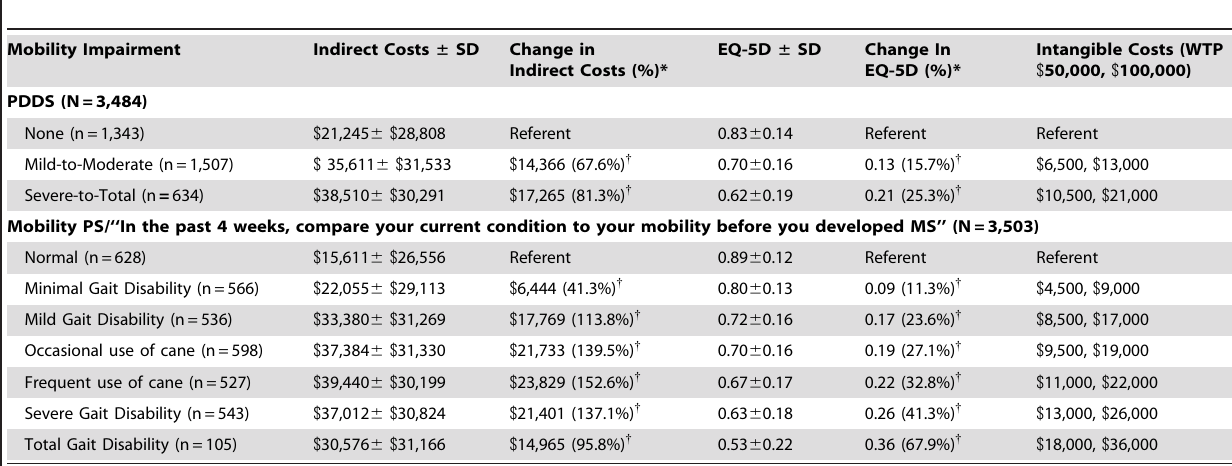
Table 2. Effect of mobility impairment categorized by Patient Determined Disease Steps and the NARCOMS Mobility Performance Scale on indirect and intangible costs #